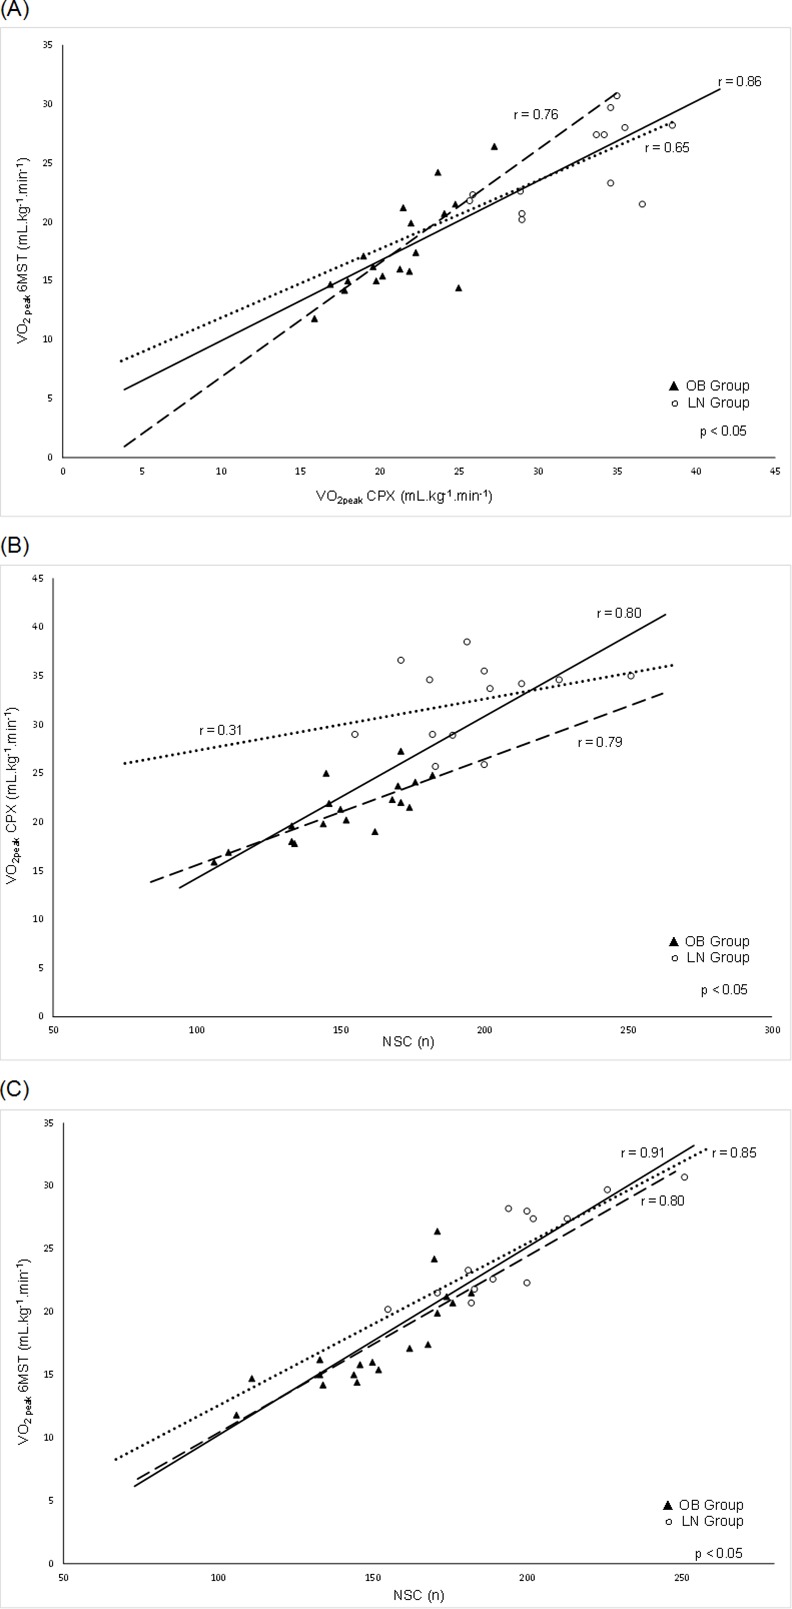
Correlations for LN, OB and overall sample for VO2peak at CPX, VO2peak and NSC at 6MST.Pearson’s coefficient correlations between cardiorespiratory fitness and functional main variables between (A) VO2peak at CPX and 6MST; (B) VO2peak at CPX and NSC; (C) VO2peak at 6MST and NSC. VO2peak, oxygen consumption at the peak of exercise; CPX, cardiopulmonary exercise testing; 6MST, six-minute step test; NSC, number of step cycles; OB, obese group; LN, lean group. Dashed line: OB; dotted line: LN; continuous line: LN and OB (overall sample).